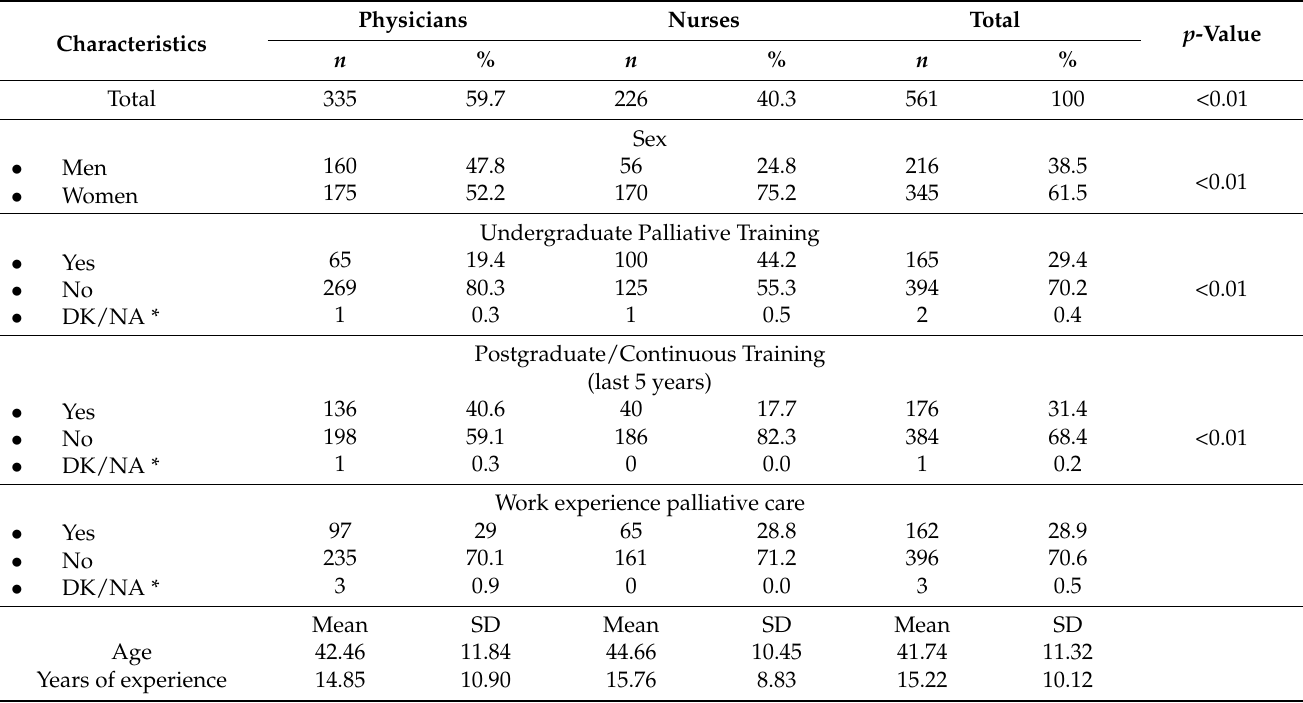
Table 1. Characteristics of the sample.